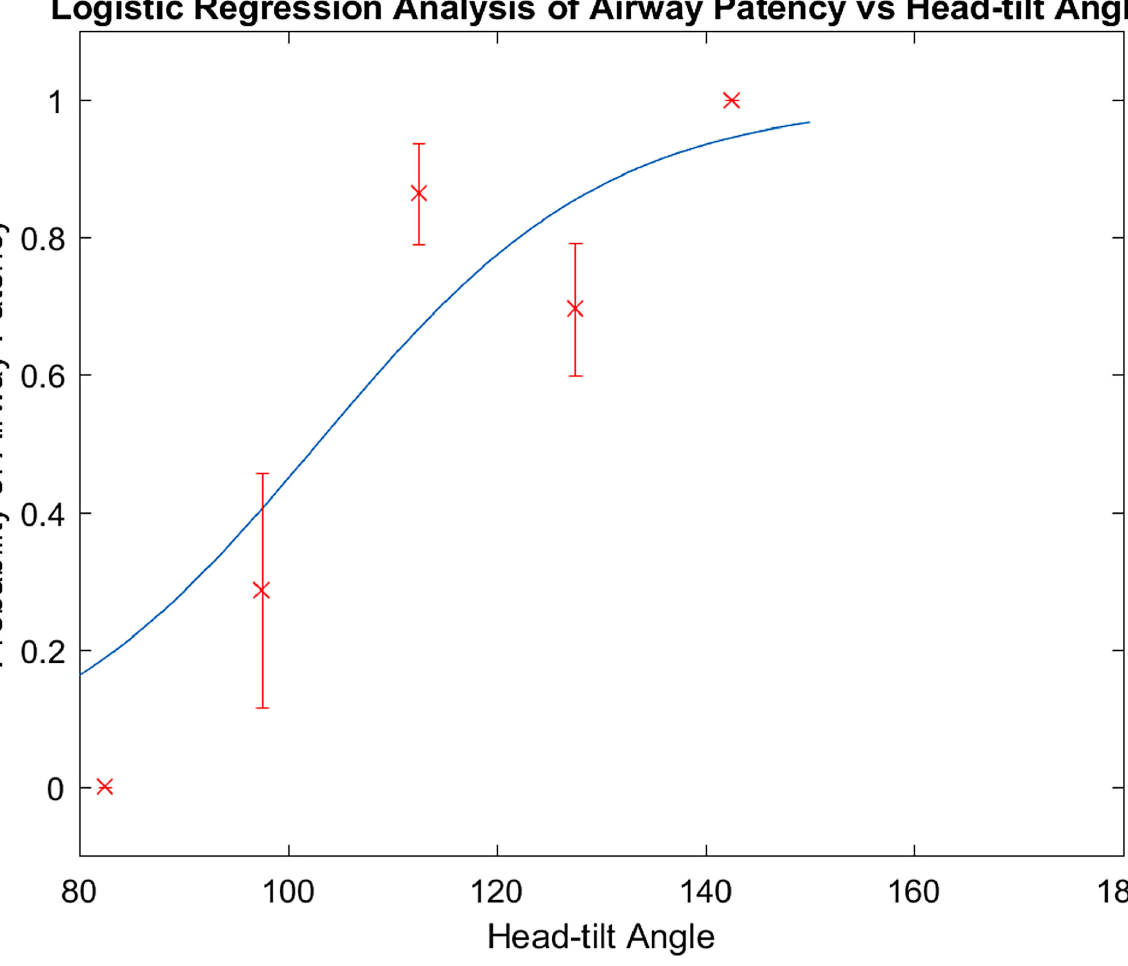
Fig 4. Logistic regression analysis of airway patency versus head-tilt angle shows that the probability of a patent airway progressively increases with increasing head-tilt angle. There is at least a 95% probability that an airway will be patent between head-tilt angle 144 – 150°. Y-axis represents the proportion of patent airways with standard error of proportion and X-axis represents 15° bins of head-tilt